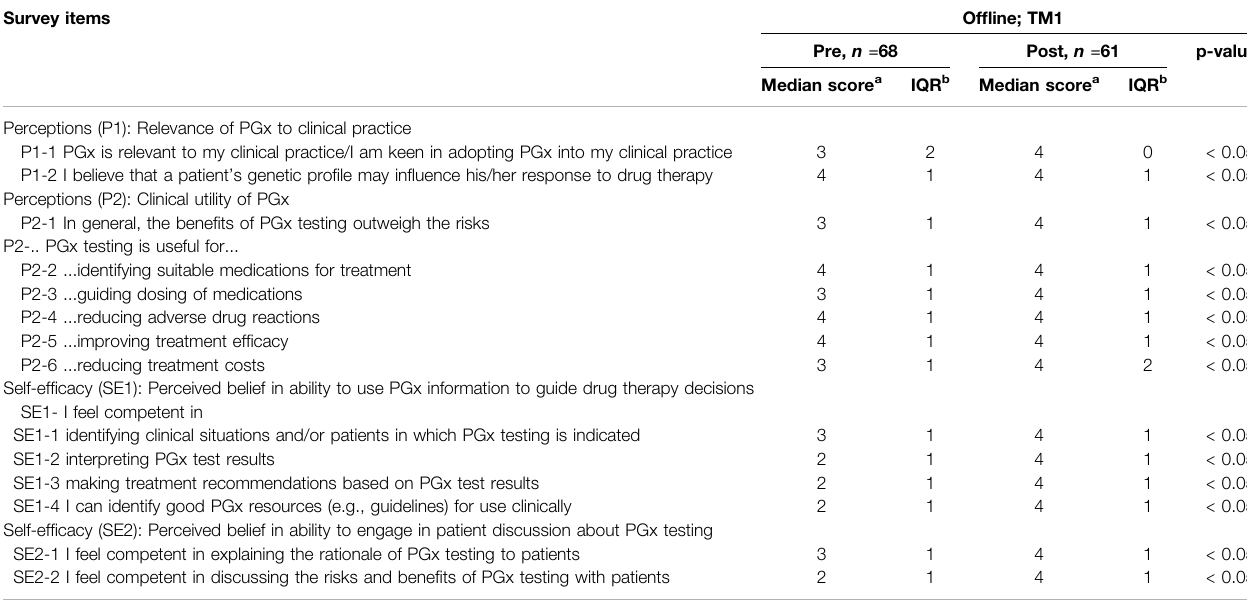
TABLE 2 | Pre- and post-of fl ine TM1 training results related to perceptions and self-ef fi cacy of addressing PGx testing. Survey items Of fl ine;